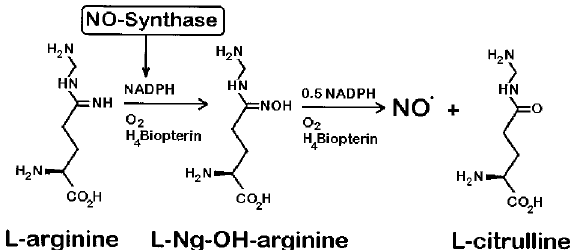
FIG. 3. Biosynthesis of NO through the so-called L-arginine- NO pathway, adapted from Ref.